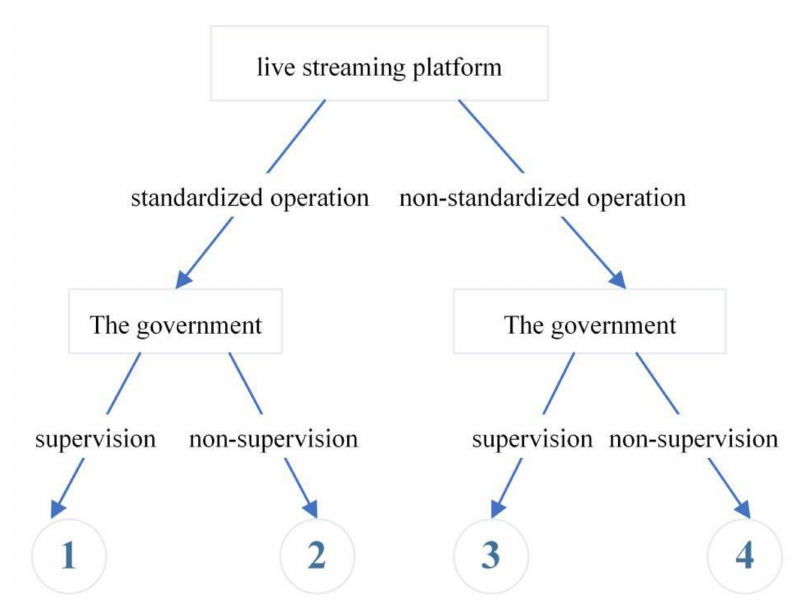
Figure 5. Game tree of “live streaming platform—the government”.